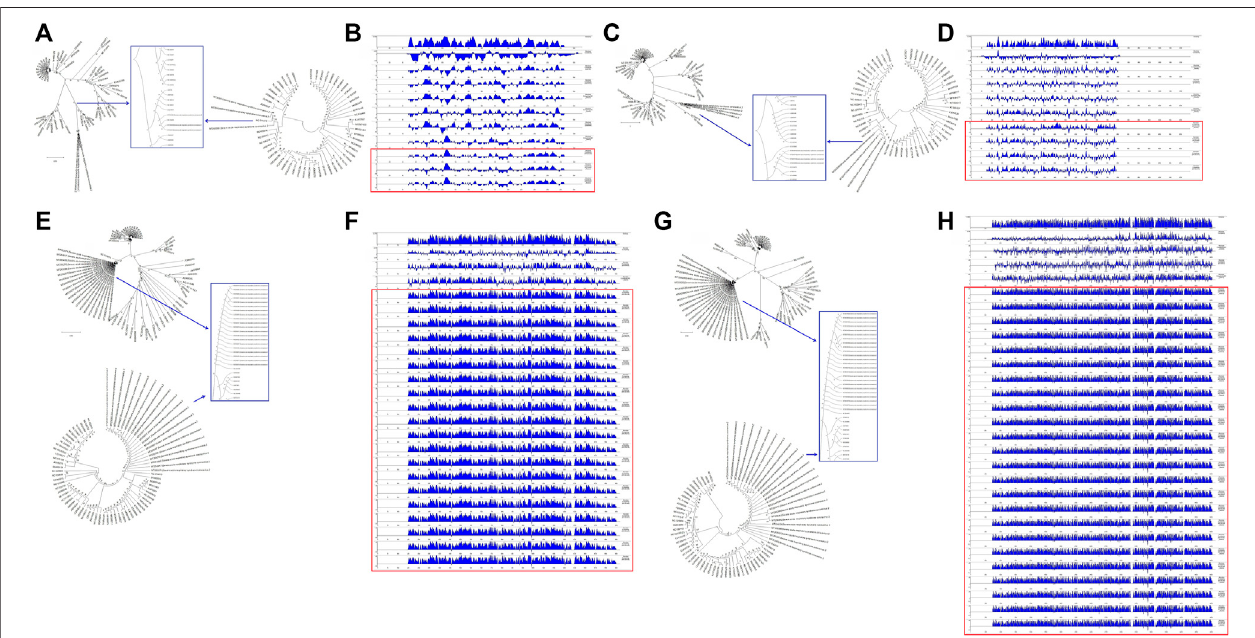
FIGURE4| Evolutionarycharacteristicsandabsolutediversitiesofstructuralgenesinsevereacuterespiratorysyndromecoronavirus-2(SARS-CoV-2)isolatesand common coronaviruses (C-CoVs) that infect other organisms. (A,C) : The E and M gene sequences of SARS-CoV-2 isolates were evolutionarily intermediates between C-CoVs that infect other organisms. (A) : In terms of E gene sequences, SARS-CoV-2 isolates were most closely related to the C-CoVs NC014470, DQ415914, NC026011, NC006213, JN874559 and U00735. (B) : The absolute diversities of the E gene sequences of the C-CoVs NC014470, DQ415914, NC026011, NC006213, JN874559, and U00735 were similar to those of the E gene sequences of SARS-CoV-2 isolates. (C) : In terms of M gene sequences, SARS-CoV-2 isolates were most closely evolutionarily related to the C-CoVs NC014470, EF065513 and NC030886. (D) : The absolute diversities of the M gene sequences of the C-CoVs NC014470, EF065513 and NC030886 were similar to those of M gene sequences of SARS-CoV-2 isolates. (E,G) : In terms of N and S gene sequences, SARS-CoV-2 isolates were most closely evolutionarily related to the C-CoV NC014470, forming a separate clade. (F) : The absolute diversity of N gene sequences of SARS-CoV-2 isolates was similar to that of the C-CoV NC014470. (H) : The absolute diversity of the S gene sequence of the C-CoV NC014470 was similar to those of other C-CoVs.